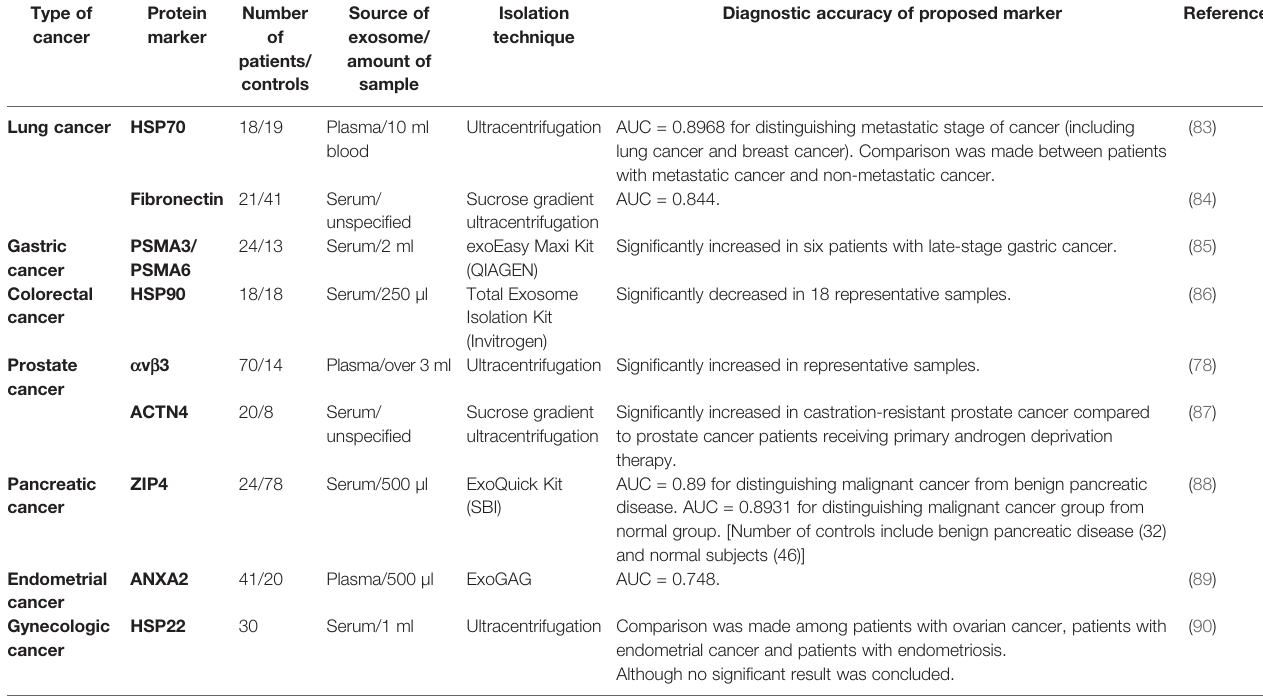
TABLE 4 | Exosomal transport protein, heat shock protein, and adhesion protein. Type of Protein cancer